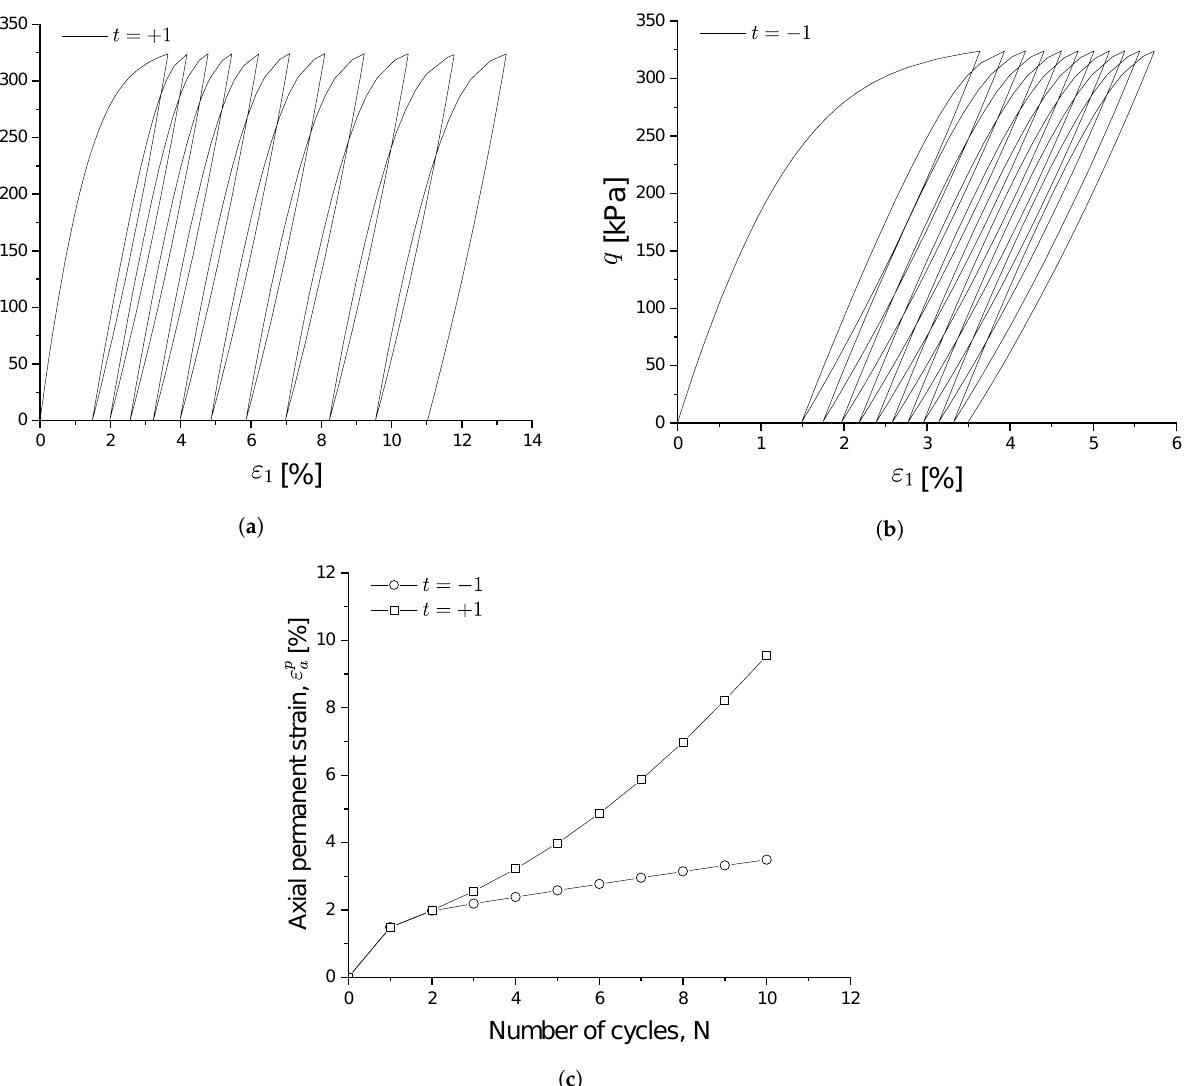
Figure 6. Influence of parameter t . ( a ) t = + 1, ( b ) t = − 1, ( c ) Deformation velocity at variable t